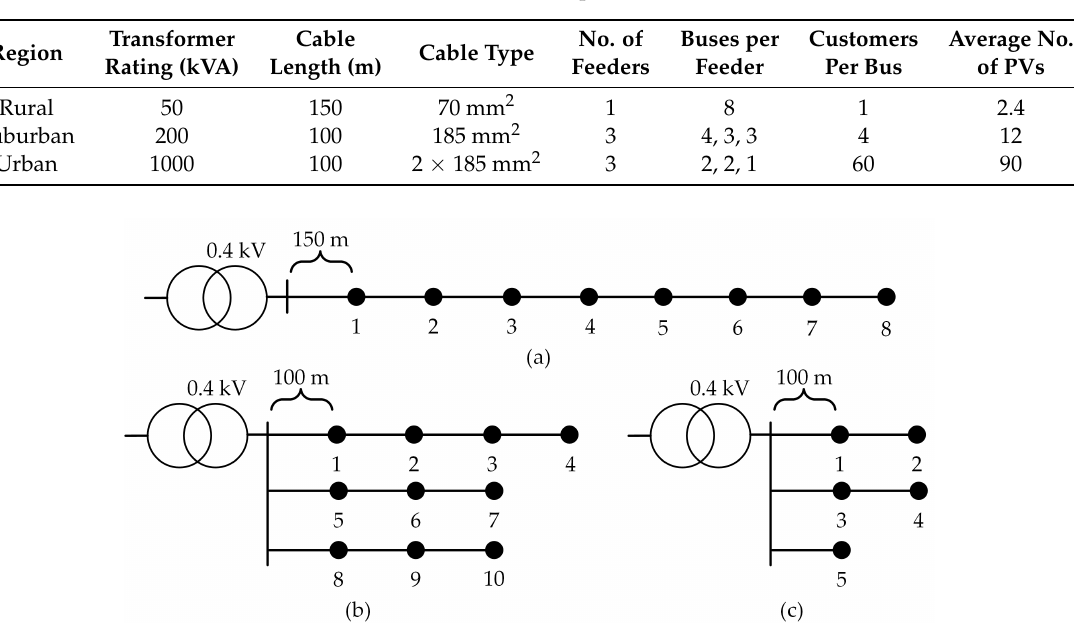
Table 1. Test network parameters.